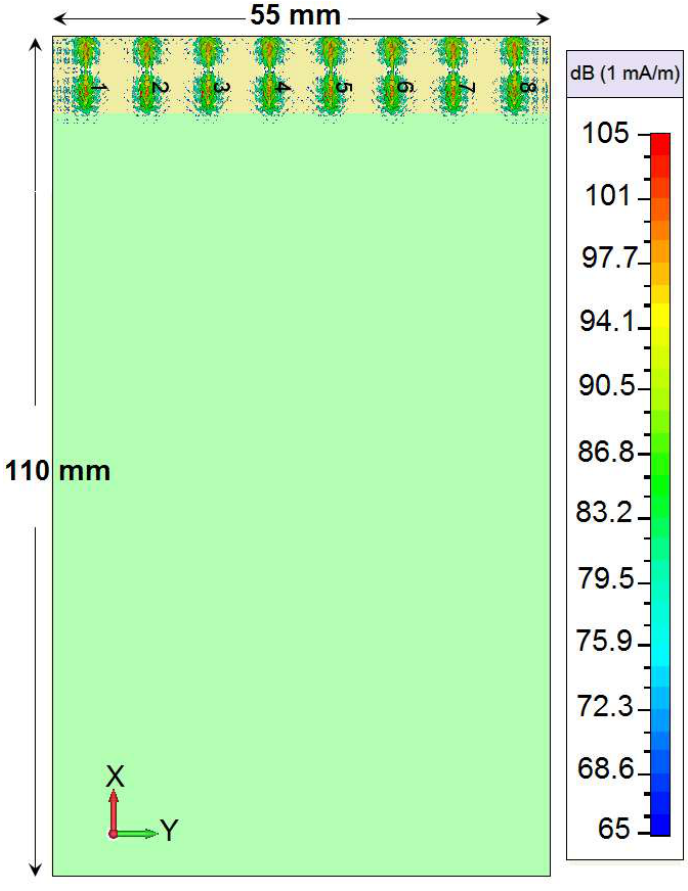
Figure 8. Current distribution at 22.25 GHz for 0 ° beam of the phased array.